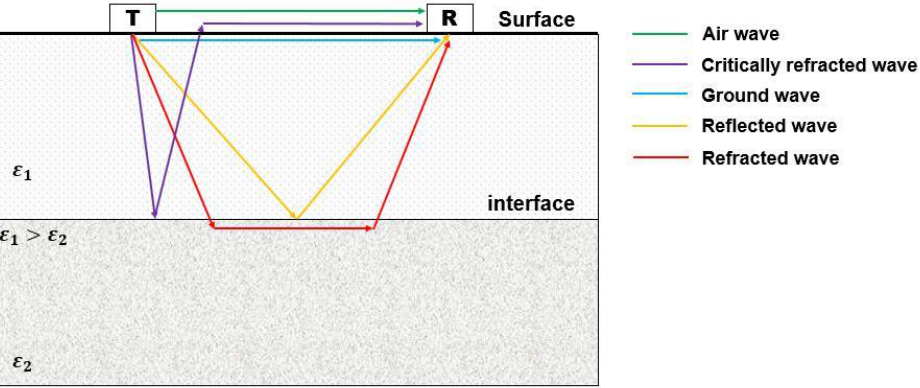
Figure 3. Propagation paths of the different electromagnetic waves in a two-layer medium with different dielectric permittivities.